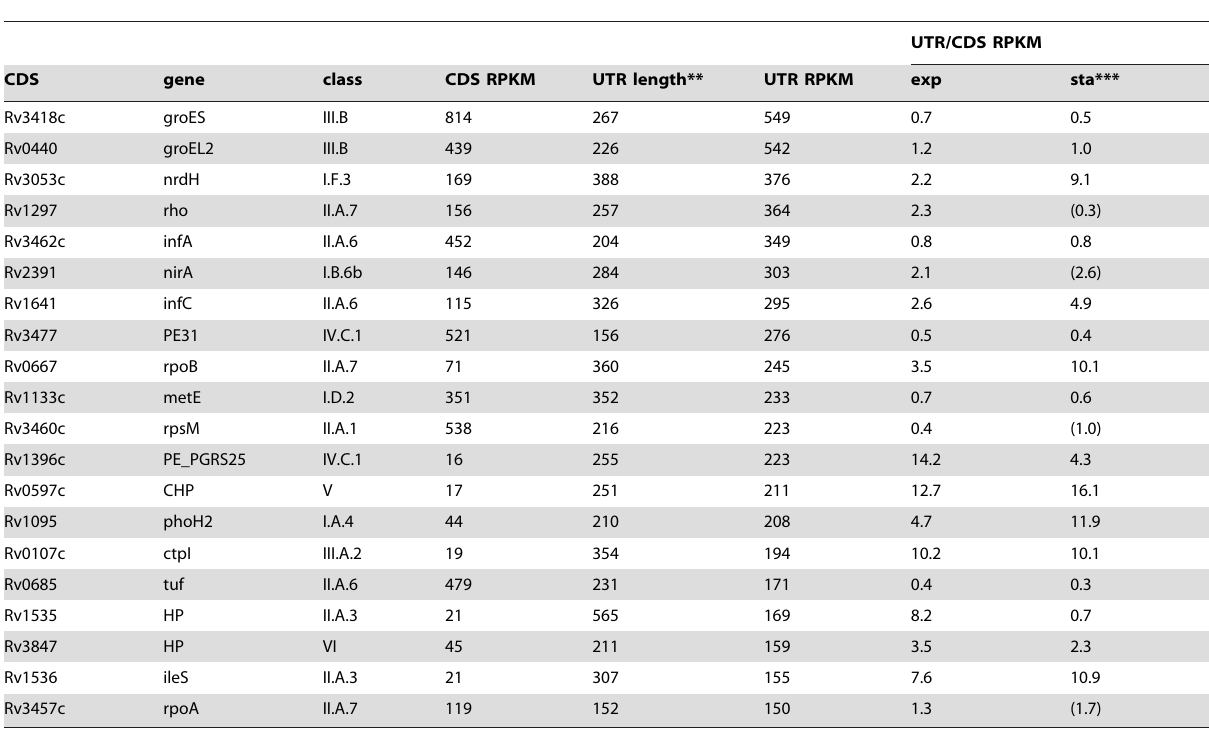
Table 8. Ranking of most abundant 5’ UTRs in intergenic